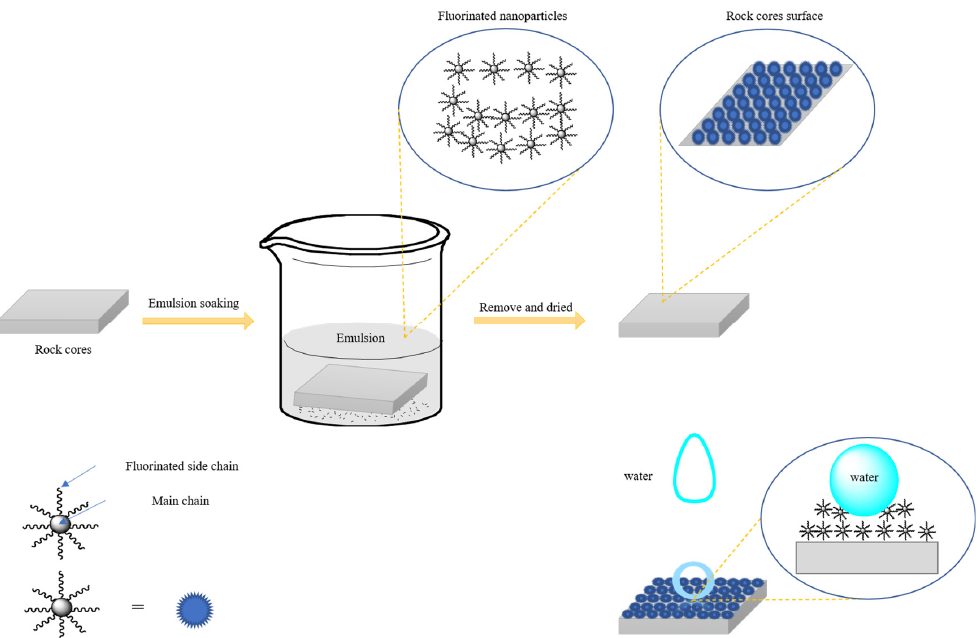
Figure 10. The schematic diagram of the hydrophobic mechanism of the nano ‐ emulsion on the rock